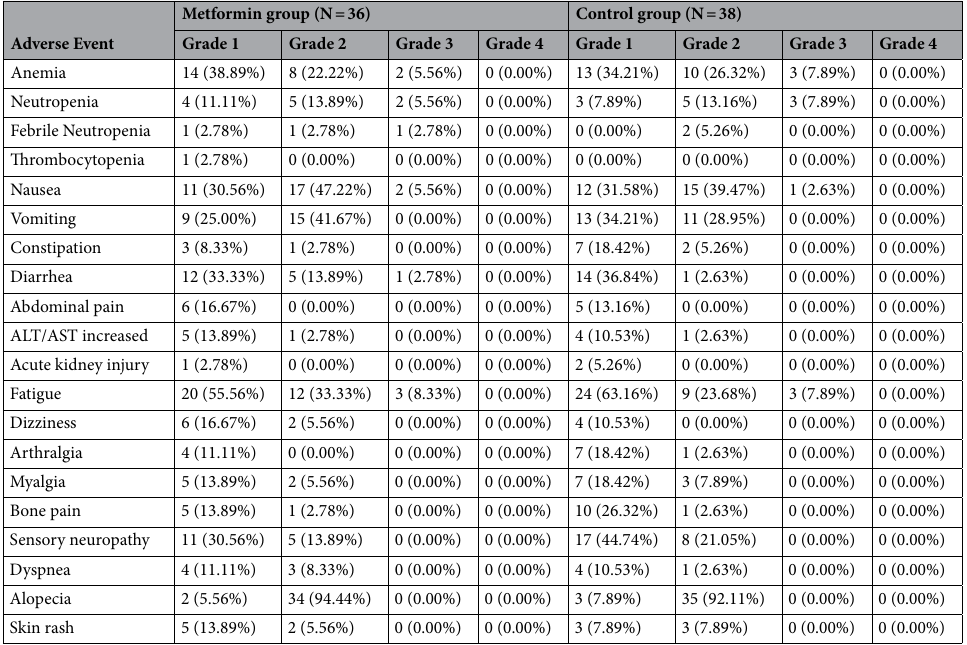
Table 4. Common adverse events reported in relation with the treatment group. ALT/AST Alanine aminotransferase/Aspartate